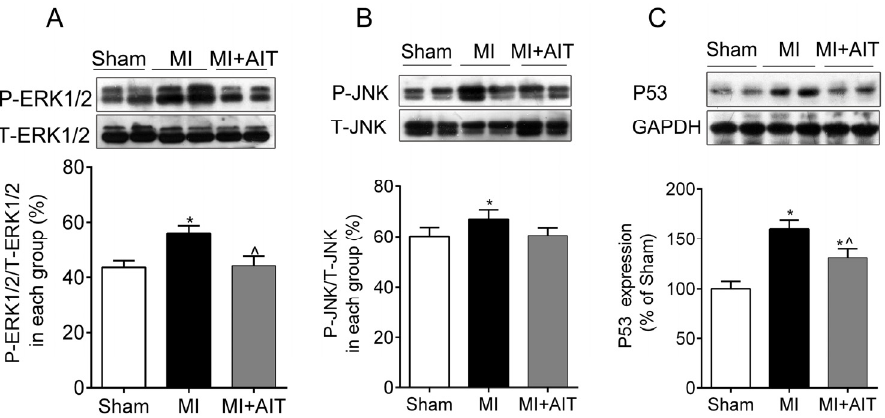
Figure 6. Effects of MI and AIT on oxidative signaling pathway. After 8 weeks, the rats were killed, and oxidative signaling protein expression was evaluated. The expression of oxidative signaling pathway ERK1/2-JNK-P53 was assessed by Western blot. ( A ) P-ERK1/2/T-ERK1/2; ( B ) P-JNK/T-JNK; ( C ) P53 expression (Top: Western blot; bottom: statistical results). Significance was calculated using one-way ANOVA followed by Tukey’s post-hoc test. The data are presented as the means ± SEM ( n = 8 for oxidative pathways). * p < 0.05 vs. the sham group; ^ p < 0.05 vs. the MI group. Sham: sham operation; MI: myocardial infarction; MI + AIT: myocardial infarcted rats subjected to aerobic interval training.